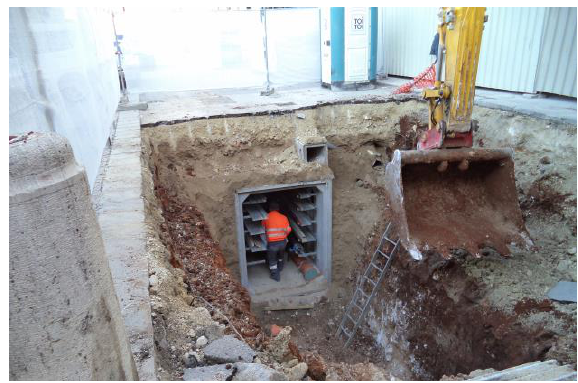
Figure 3. View of the internal part of underground tunnel set up along Corso Vittorio Emanuele II